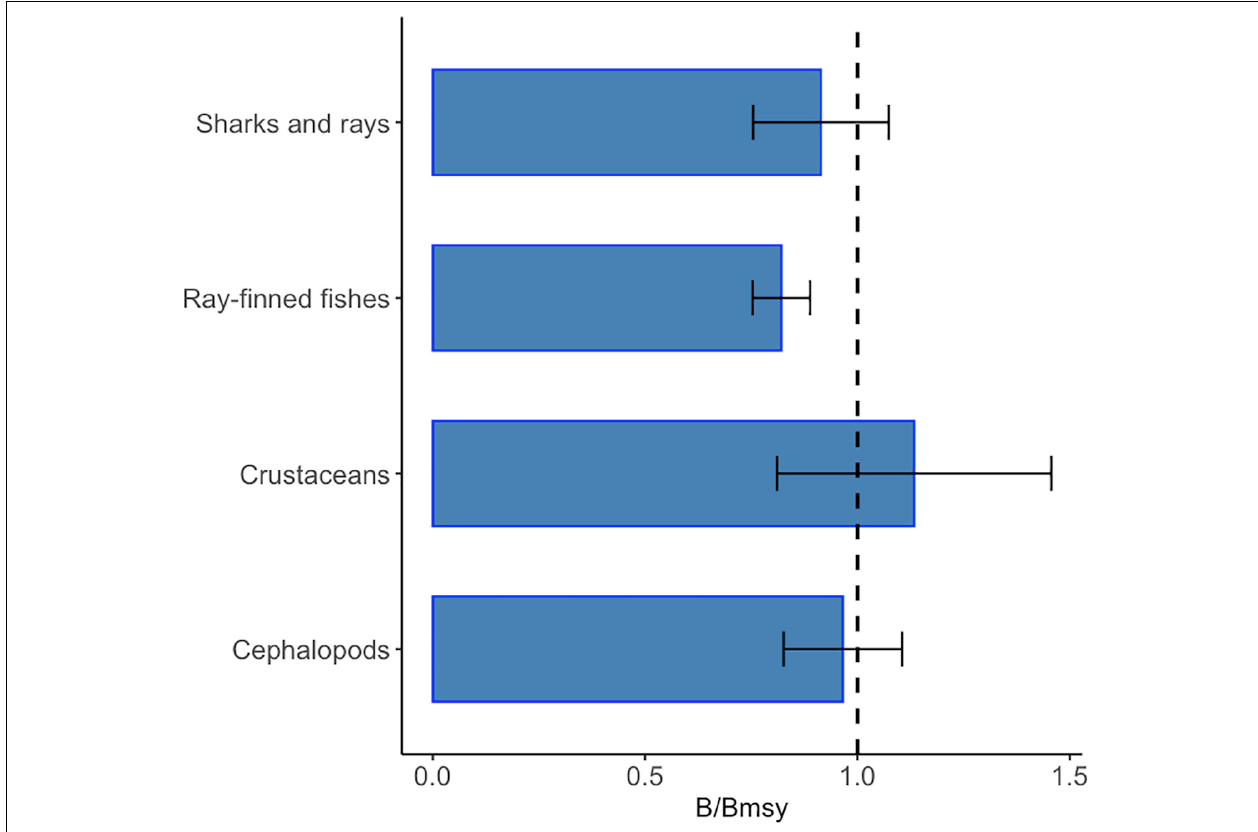
FIGURE 2 | Histogram of the mean B/B msy per taxonomic group for the 74 fish and invertebrate stocks of the Aegean Sea assessed using the AMSY method. The vertical dashed line denotes the limit for healthy stock status (B > B msy